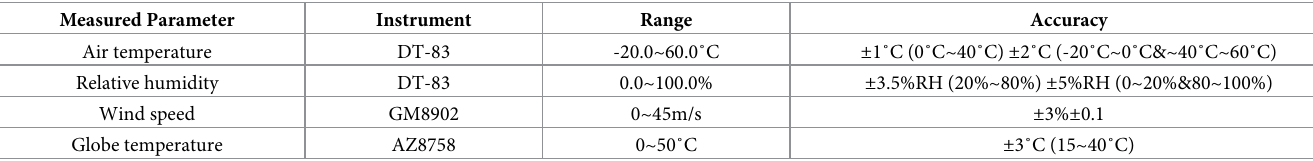
Table 1. Experimental equipment used for the measurement of micrometeorological parameters. Measured